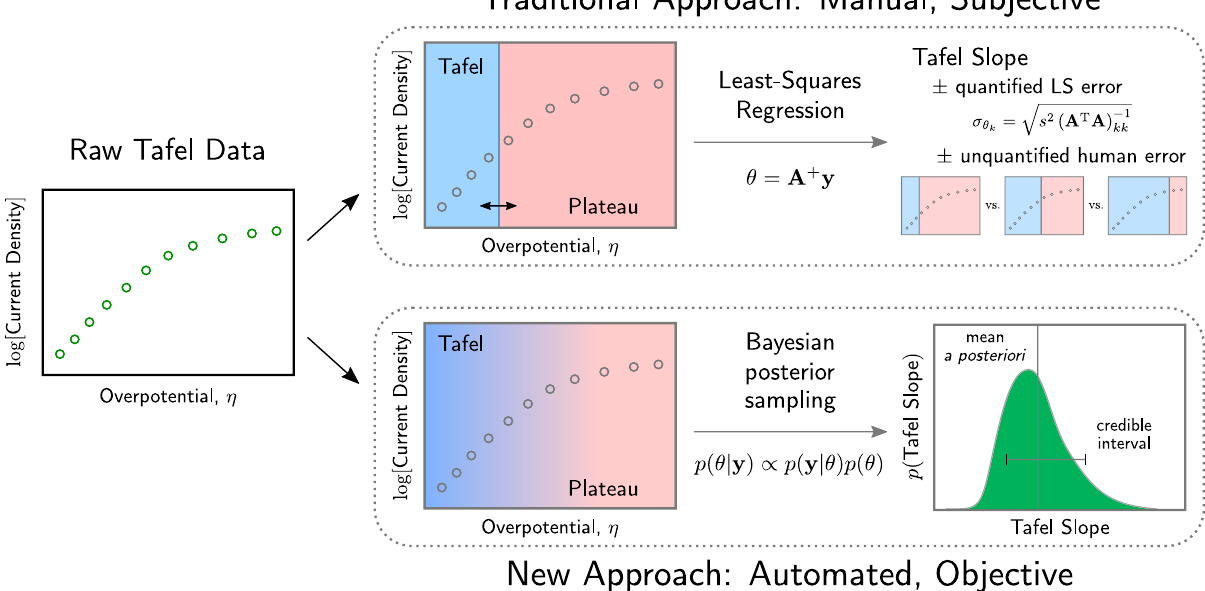
Fig. 1 Schematic comparison of the traditional approach to Tafel fi tting and the new approach we describe in this paper. Starting from raw current – voltage data on the left, the current literature approach begins with manual identi fi cation of a linear Tafel region on the plot. The rest of the data is discarded, and a linear fi t to the Tafel region yields a Tafel slope, with an associated uncertainty corresponding to the standard error of the ordinary least- squares (OLS) estimator. In addition to this quanti fi ed uncertainty, an additional unquanti fi ed source of uncertainty arises from the manual selection of a Tafel region on the plot. The new approach described here considers all of the data in the context of a nonlinear model that smoothly interpolates between the traditional Tafel region and a plateaued region (e.g., due to mass transport limitations). Our approach uses a Monte Carlo method to sample from the Bayes posterior distribution over the parameters of the model, yielding a probabilistic distribution over Tafel slopes that are consistent with the measured